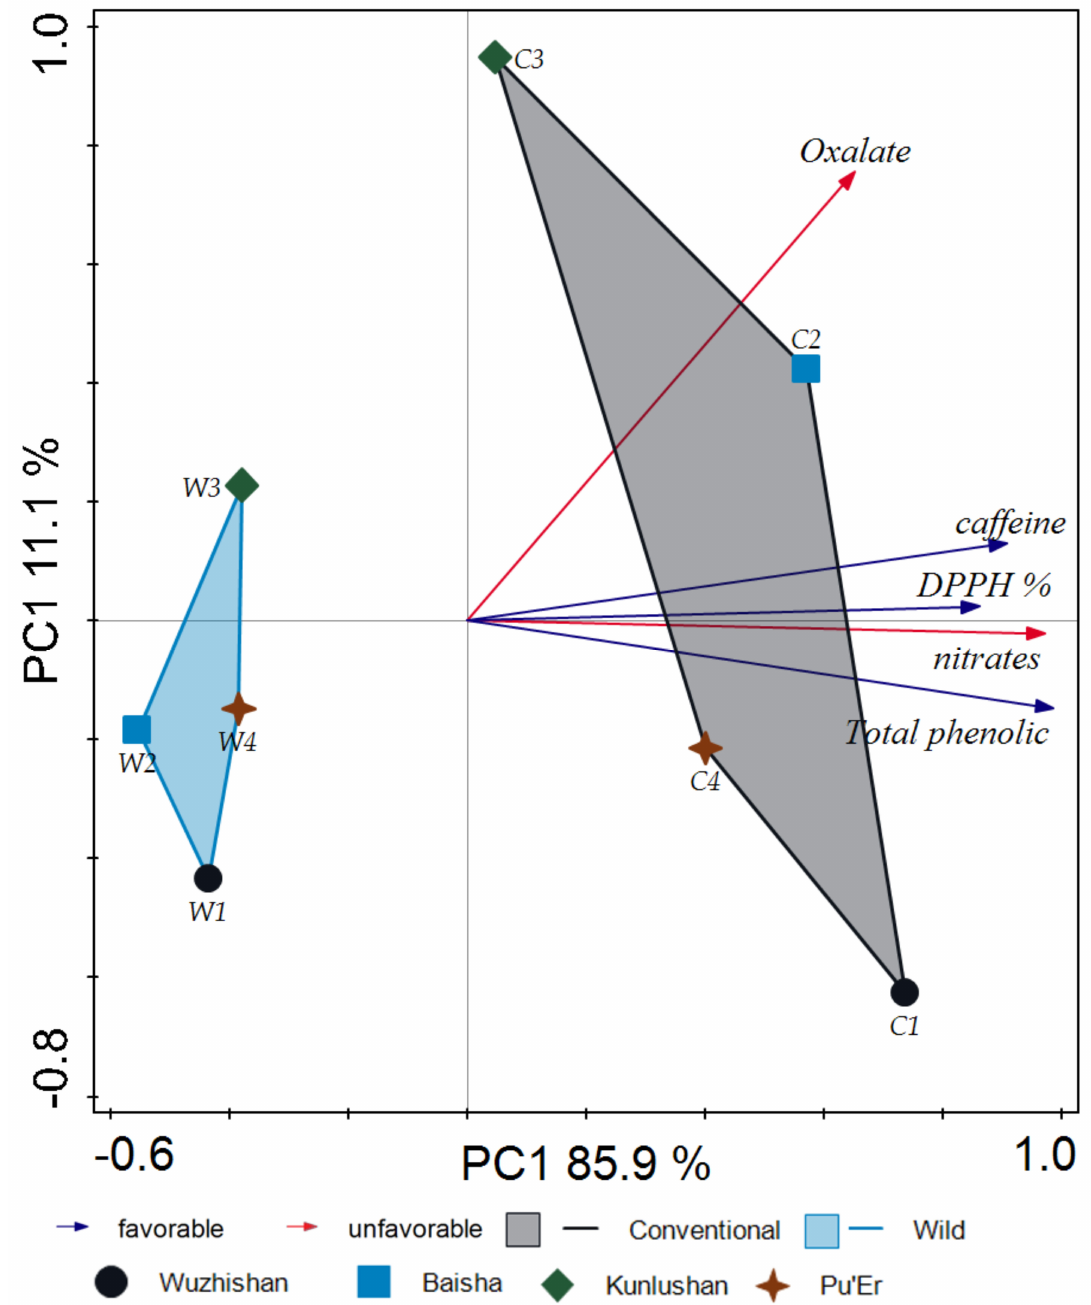
Figure 8. Principal component analysis (PCA) score derived from oxalates, nitrates, caffeine content, DPPH, and total phenolic content of 64 tea samples: W1-wild tea, Wuzhishan; W2-wild tea, Baisha; W3-wild tea, Kunlushan; W4-wild tea, Pu’Er; C1-cultivated tea, Wuzhishan; C2-cultivated tea, Baisha; C3-cultivated tea, Kunlushan; C4-cultivated tea,